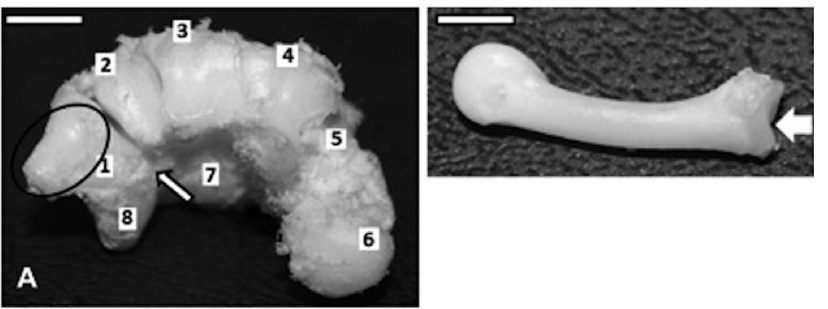
Figure 1. Bones and ligaments in a capuchin left hand. A) surface of carpo-metacarpal joint. The black circle highlights the convex lateral joint surface of trapezium bone with metacarpal; the arrow indicates the central bone; 1) trapezium; 2) trapezoid; 3) capitate; 4) hamate; 5) pyramidal; 6) pisiform; 7) lunate; 8) scaphoid (bar=4.0 cm). B) Lateral view of metacarpal I. The white arrow indicates the concave surface joint that connects with the trapezium bone (bar=2.0 cm).